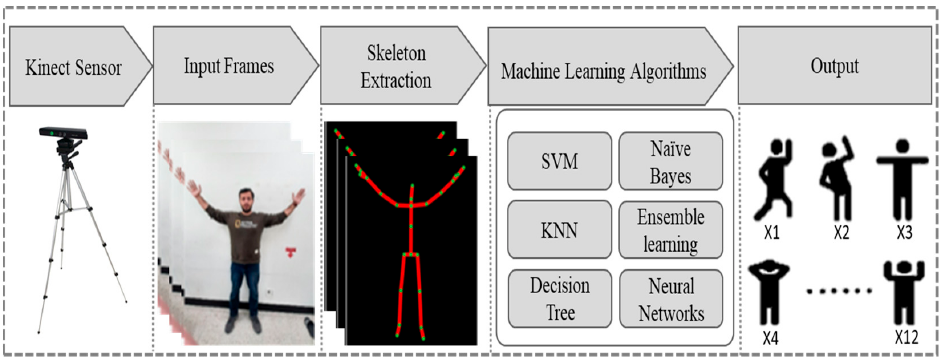
Figure 3. Activity recognition through different Machine learning algorithms.